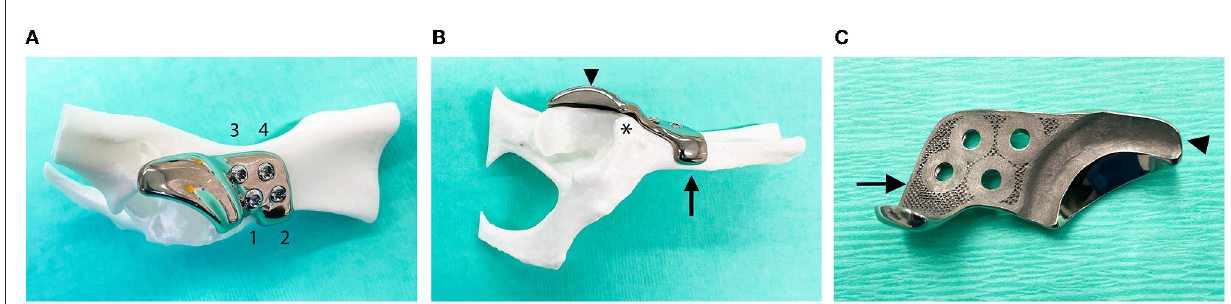
FIGURE2 Photographs of the titanium shelf implant for acetabular rim extension. (A) The implant was fixed on the right ilium of a 3D-printed plastic model of a dog’s pelvis using one cortical screw (1) and three locking screws (2–4). (B) Ventral ilium flange (arrow) of the attachment part cranial to the insertion of the rectus femoris muscle (*) improved positioning and stabilization of the implant. The acetabular rim extension part (arrowhead) of the implant increased femoral head coverage. (C) The bone-facing back side of the implant showed the porous surface (arrow) at the attachment part and offset (arrowhead) of the acetabular rim extension part.